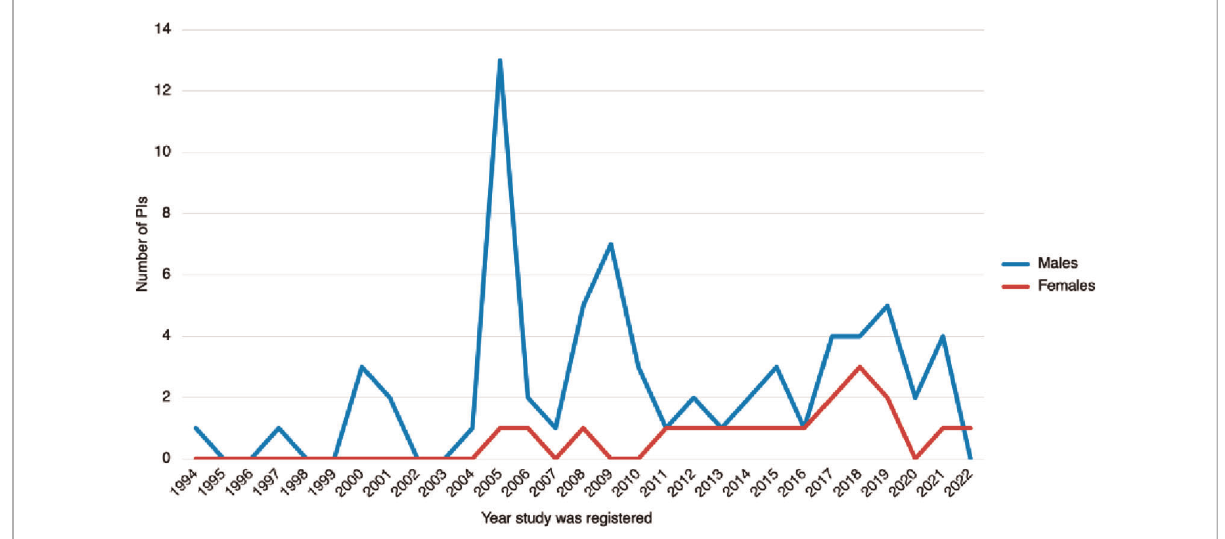
FIGURE 1 Trend over time of principal investigators within AGITG. Each trial is represented once, in the year it was